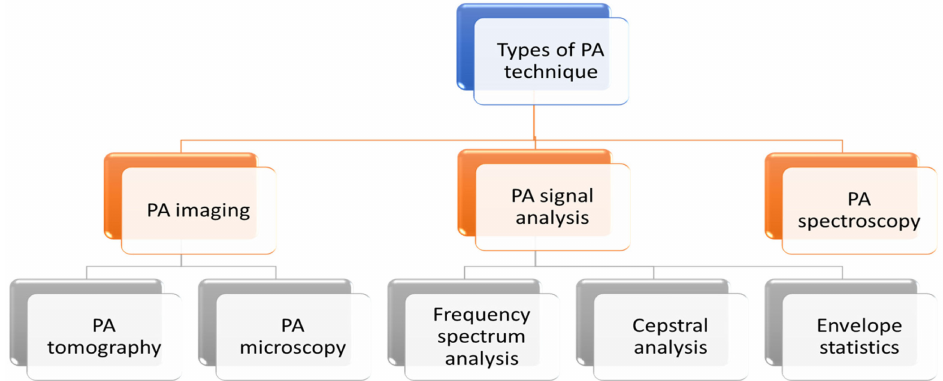
Figure 3. Different types of PA techniques.